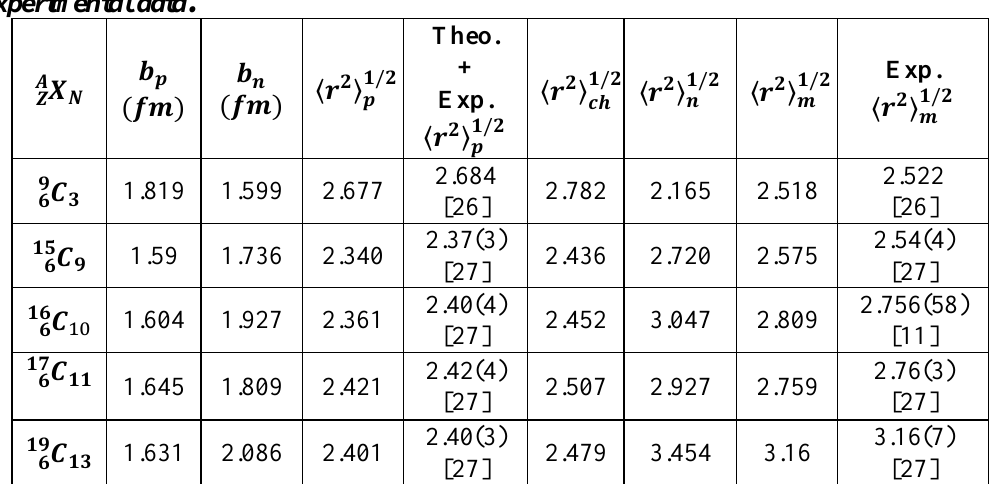
Table 7: Calculated proton, charge, neutron, matter radii in Fermi’s for Carbon isotopes 9 C, 12 C, 13 C, 15 C, 16 C, 17 C and 19 C by using HO technique compared with available experimental